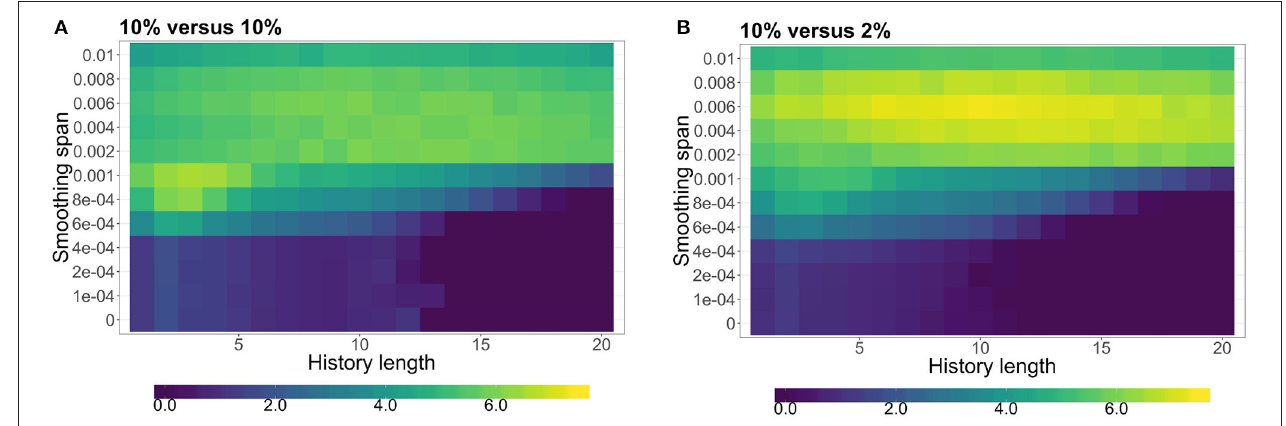
FIGURE 3 | Total transfer entropy (TTE) as a function of the history length ( k ∈ { 1, ..., 20 } ) and of the LOWESS smoothing span (smoothing span ∈ { 0, 0.0001, ..., 0.01 } ). (A) The symmetric food choice condition with two 10% w/v oat-agar blocks where TTE is maximized for history length k = 3 and smoothing span 0.001. (B) The asymmetric food choice condition with 10% w/v and 2% w/v oat-agar blocks where TTE is maximized for history length k = 10 and smoothing span of 0.006.